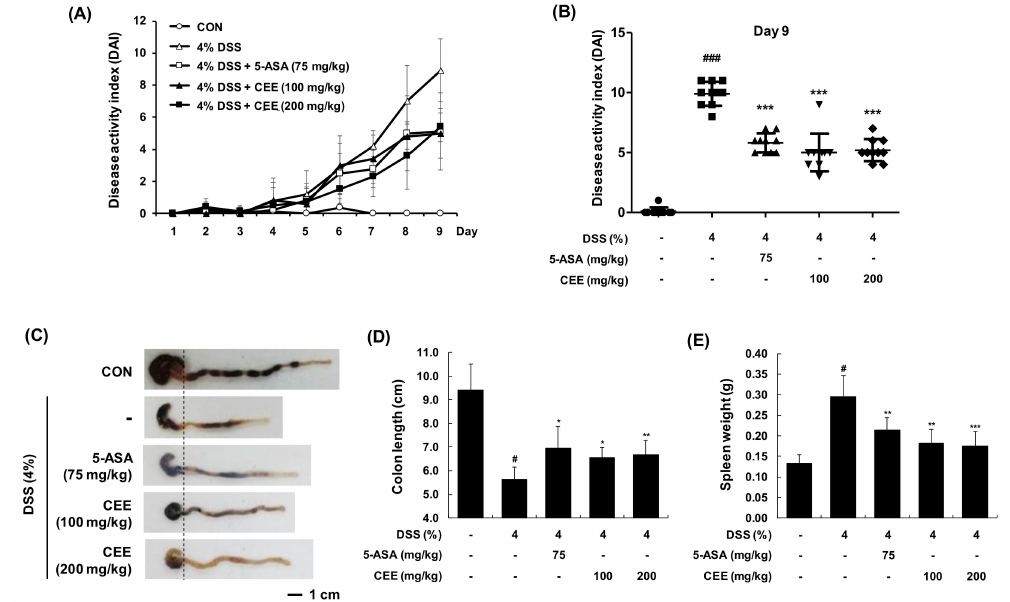
Figure 3. E ff ects of CEE on DSS-fed mice with colitis. ( A ) Disease activity index (DAI) levels during total experiments periods and ( B ) at the end of the experiment (day 9). Data are presented as mean ± SDs ( n = 10). ### p < 0.001 vs. the vehicle-fed control group; *** p < 0.001 vs. the DSS-fed colitis group in a Mann-Whitney nonparametric t -test, 95% confidence. ( C ) Macroscopic images of the colon in each group were observed and ( D ) colon length was measured. ( E ) Experimental animals’ spleen weights. Data are presented as mean ± SDs ( n = 10). # p < 0.001 vs. the vehicle-fed control group; * p < 0.05, ** p < 0.01, *** p < 0.001 vs. the DSS-fed colitis